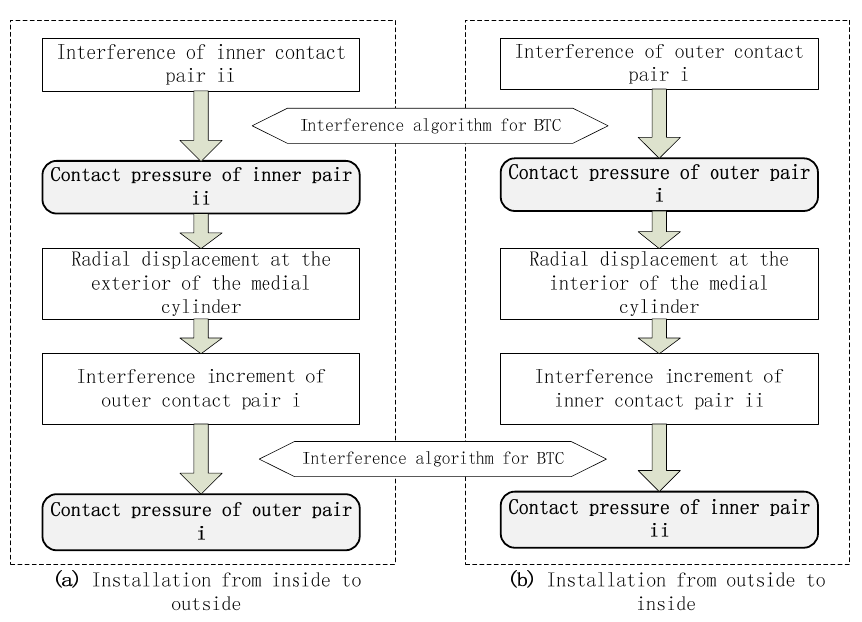
Figure 4. Calculation flow diagram for interference algorithm for tri ‐ layer thick ‐ walled cylinders (TTC) with different assembly sequence. ( a ) installation from inside to outside: proceeding from the interference of inner contact pair ii , the contact pressure of outer pair i can be calculated by updating the interference of outer contact pair i ; ( b ) installation from outside to inside: proceeding from the interference of outer contact pair i , the contact pressure of inner pair ii can be calculated by updating the interference of inner contact pair ii .